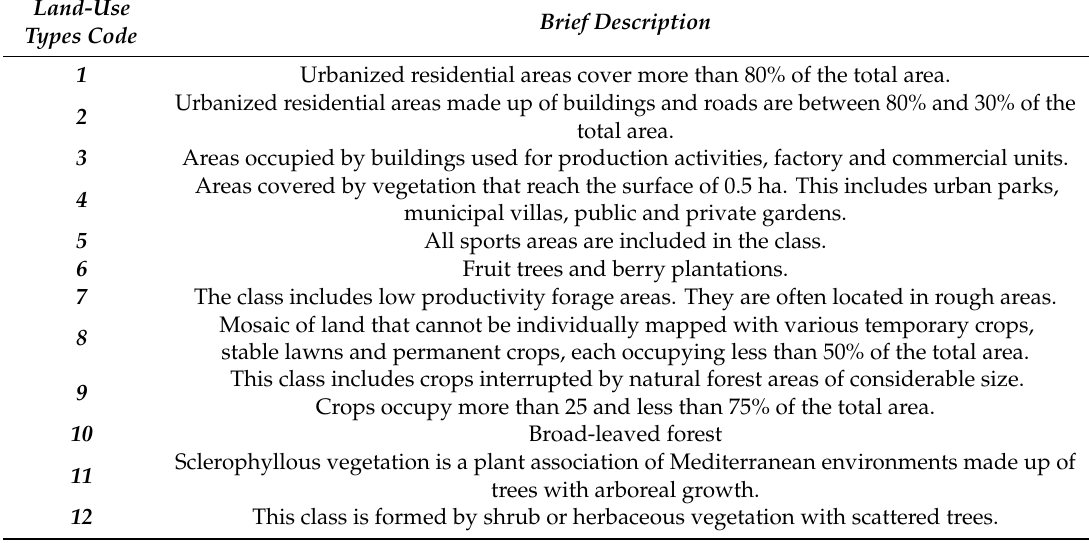
Table 1. Land-use types’ code